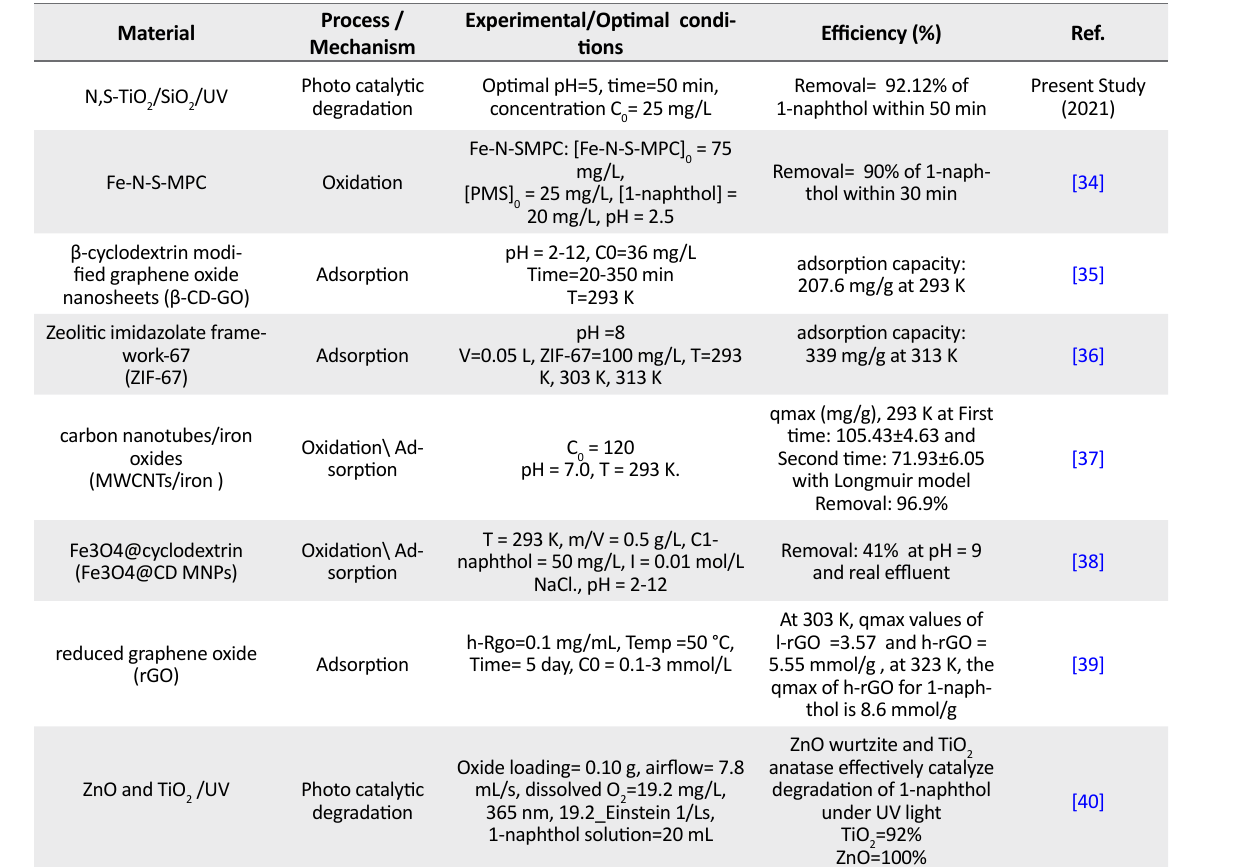
Table 1. Efficiency of 1-n aphthol removal by conventional